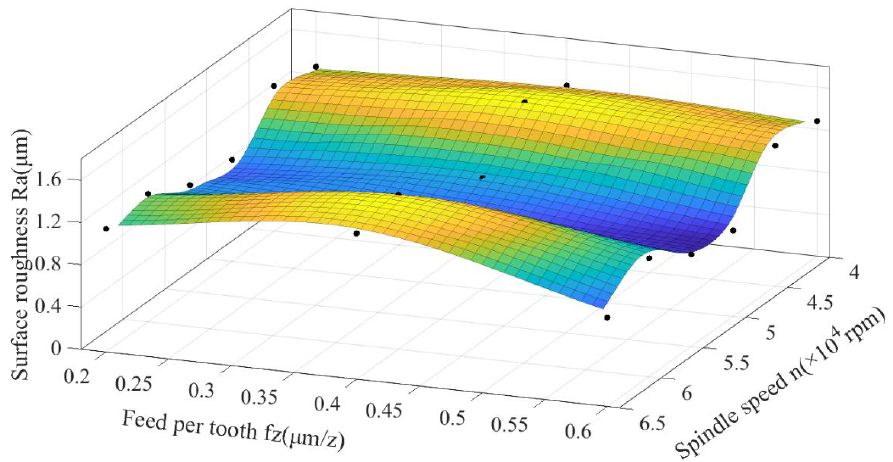
Figure 6. Surface roughness under the cutting parameters of Table 1.